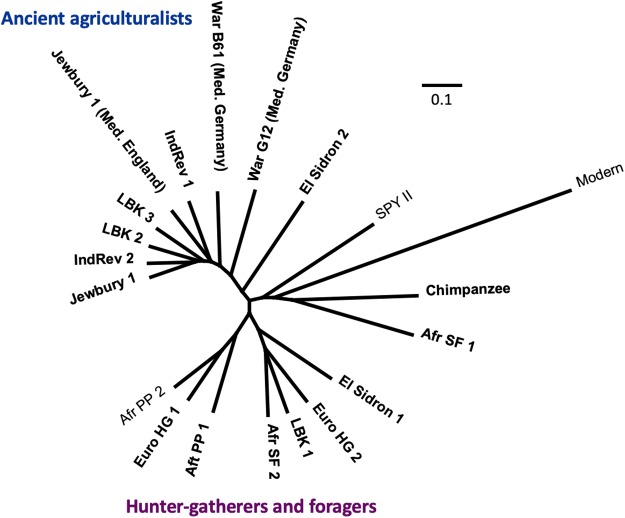
UPGMA tree of species-level Bray–Curtis dissimilariies calculated from the microbial composition between each sample.The branch scale bar represents the Bray–Curtis dissimilarity between samples.